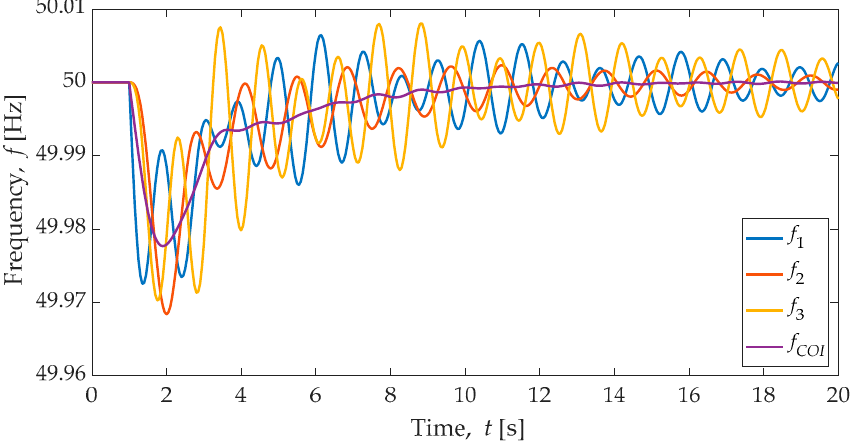
Figure 13. Frequency response ( f in Hertz) in a three-area system, including the centre of inertia ( f COI ) , considering a sudden load increase ( Δ P L ) in Area 1.